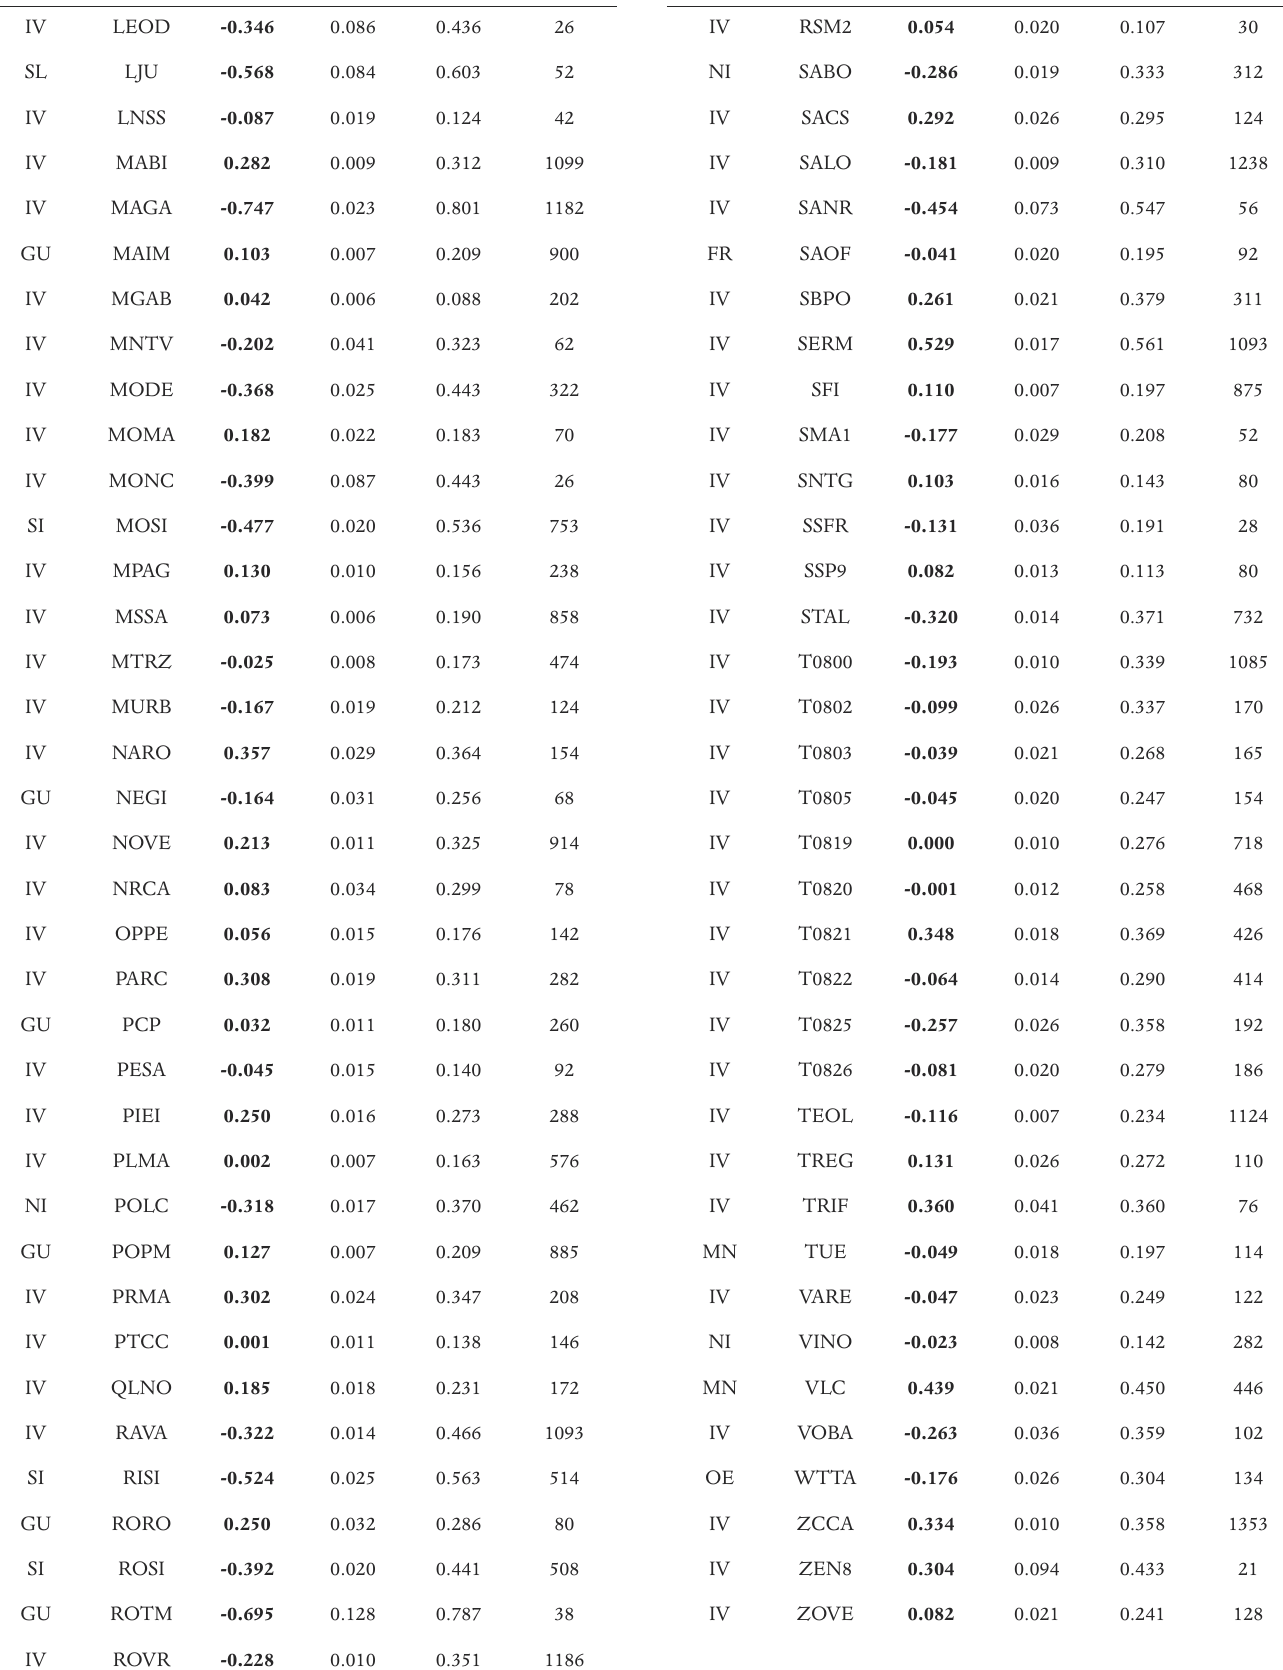
Table A1 (from top to bottom, and from the right column to the left column; continued from previous